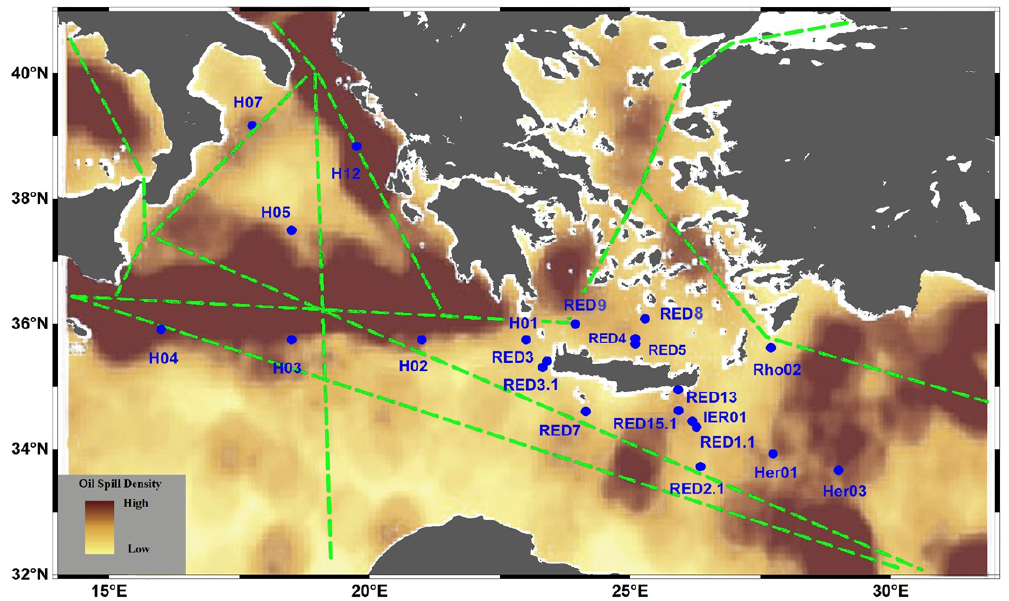
Fig. 6. Sampling sites, oil spills’ normalized density reported in the study area for the years 1999–2004 (modified after Ferraro et al., 2007; reprinted from Ferraro et al., 2007, copyright (2007), with permission from Elsevier) and main EMS tanker/crude oil shipping routes (REMPEC,